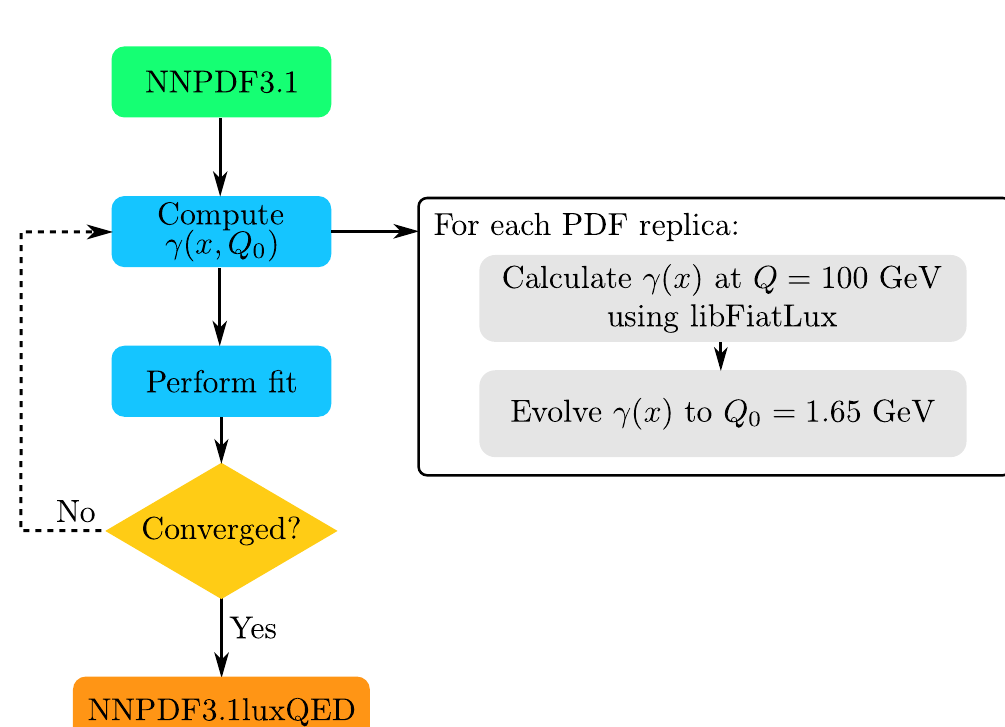
Figure 2.2: Flow diagram representing the NNPDF3.1luxQED fitting strategy. In the last iter- ation n , once the procedure has converged, the additional LUXqed17 are added to γ ( x , Q ) , ite see Sect.